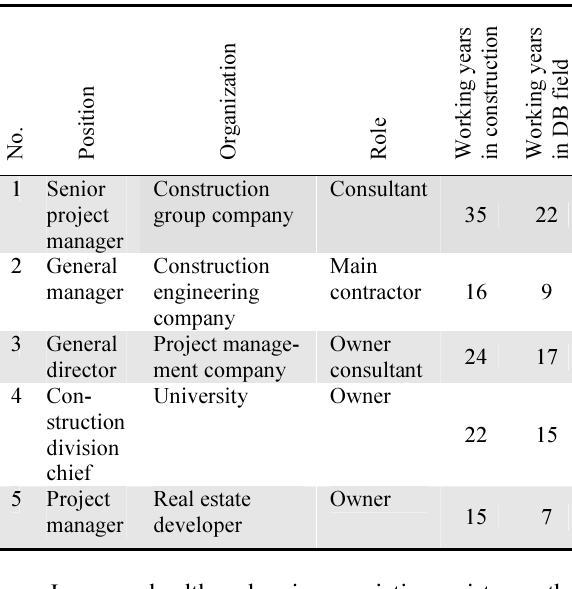
Table 9. Interviewees’ details for validating selection criteria for DB operational